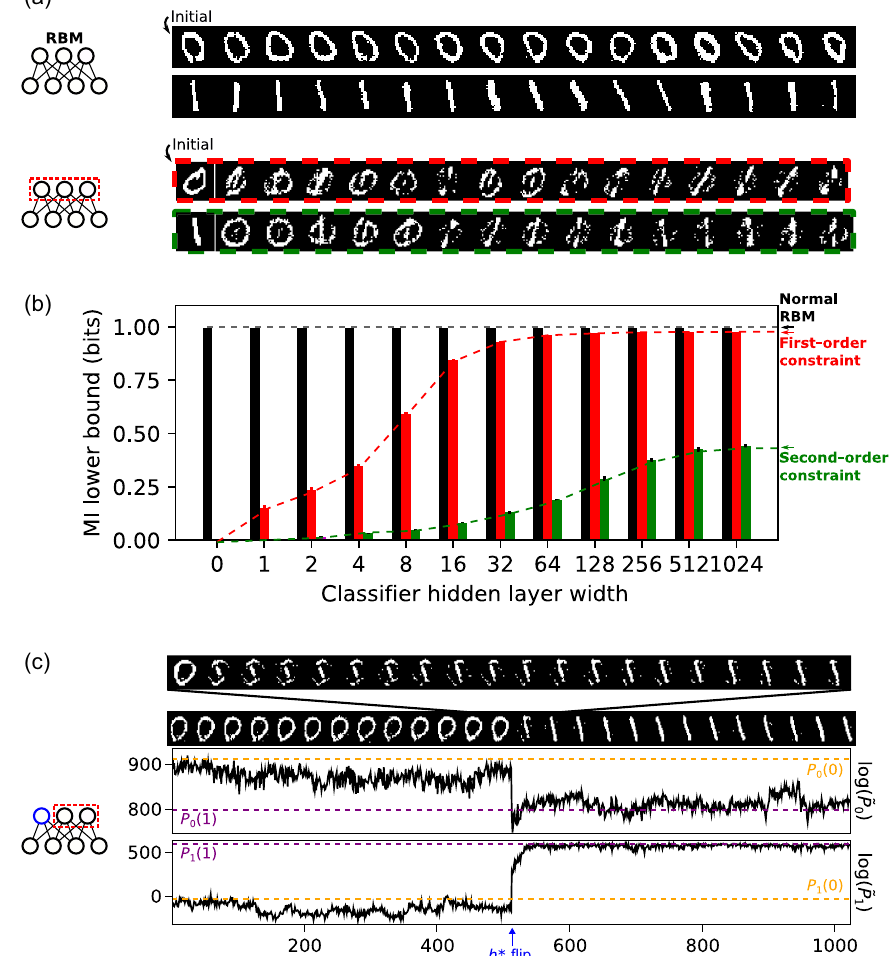
FIG. 8. Manipulating representations of the RBM trained on MNIST 0 = 1 . (a) Samples generated by the RBM initialized with a data image (0 or 1). Top two rows show a standard (unconstrained) RBM. Bottom two rows show samples from the RBM trained with linear (red dashed) and quadratic (green dashed) constraints. In both cases, a Markov chain is generated by Gibbs sampling (starting from a 0 or 1 data digit), and images are saved every 64 steps, until reaching a total of 16 samples as shown. (b) Lower bound S mutual information between inputs and labels [see Eq. (25)] vs classifier width. The bounds to MI are measured in bits and shown in discontinuous lines. Colors correspond to the different RBM models. Black: standard and unconstrained. Red: fully constrained with linear constraints; see Eq. (6). Green: fully constrained with quadratic constraints; see Eq. (9). (c) Samples from the RBM trained with first-order constraint acting on all but one hidden unit, which is flipped at the middle of the MC chain (blue arrow). Starting from a 0 data digit, samples are saved every 64 Gibbs steps. Top panel shows an enlarged view of the transition, with images every three steps instead. The lower panels show the logarithm of the unnormalized probability ln RBMs, evaluated on RBMs trained only on 0s (RBM0) or 1s (RBM1). Purple and orange dashed lines correspond to the average ln of data digits 0 and